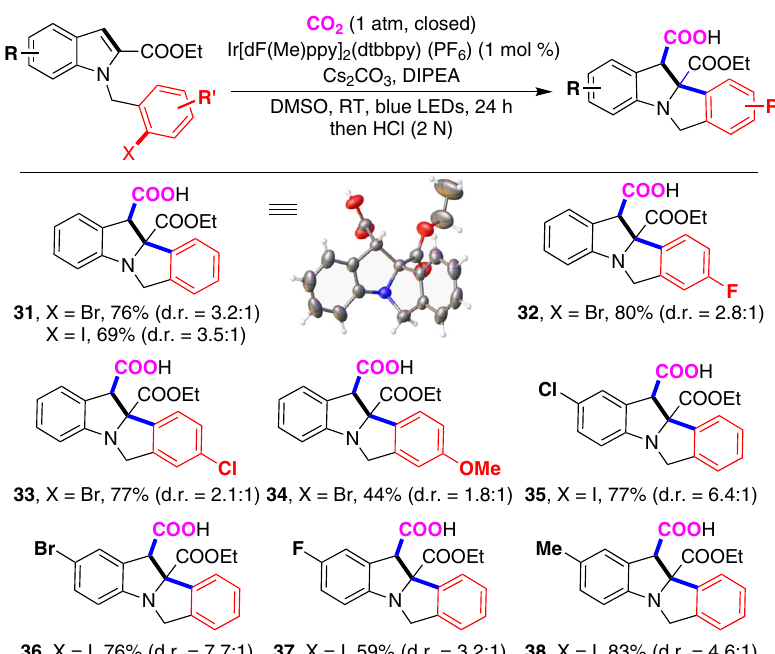
Fig. 4 Scope of substrates bearing unactivated aryl bromides and iodides. Reaction conditions: Indole derivatives (0.2 mmol), Ir-catalyst (0.002 mmol), Cs 2 CO 3 (0.6 mmol), DIPEA (1.3 mmol), DMSO (2 mL), 1 atm of CO 2 , 30 W blue LEDs, RT, 24 h, isolated